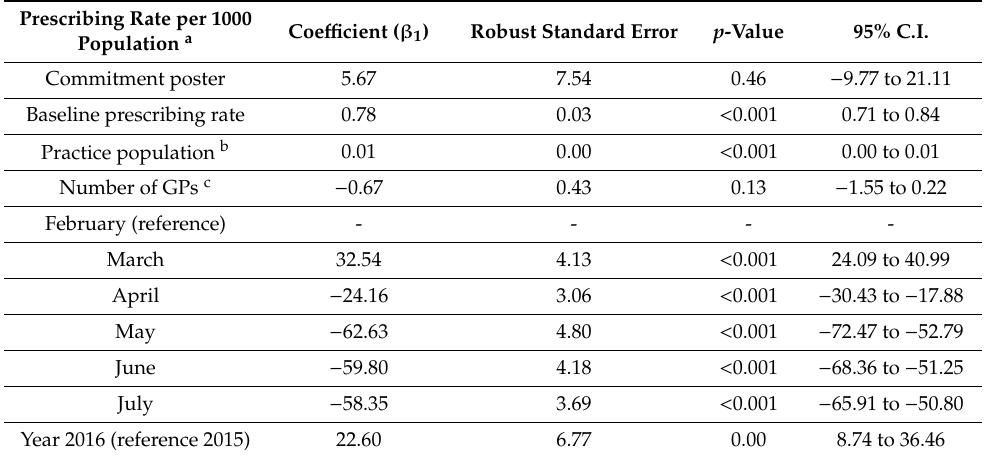
Table 1. Regression estimates for the e ff ect of the commitment poster on the number of antibiotic items prescribed.